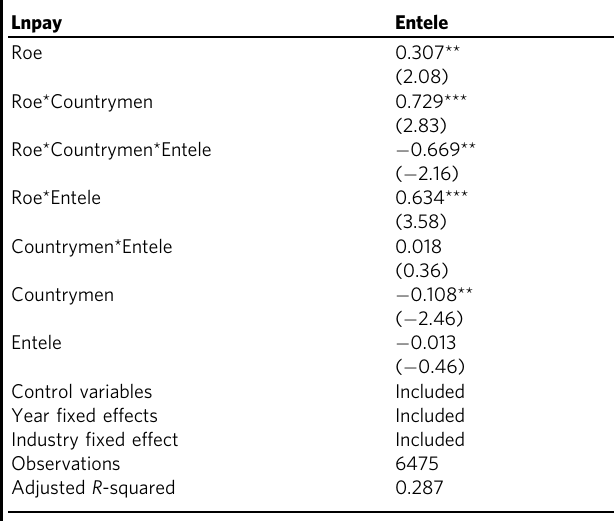
Table 12 In fl uence mechanism based on the appointment method of CEO.